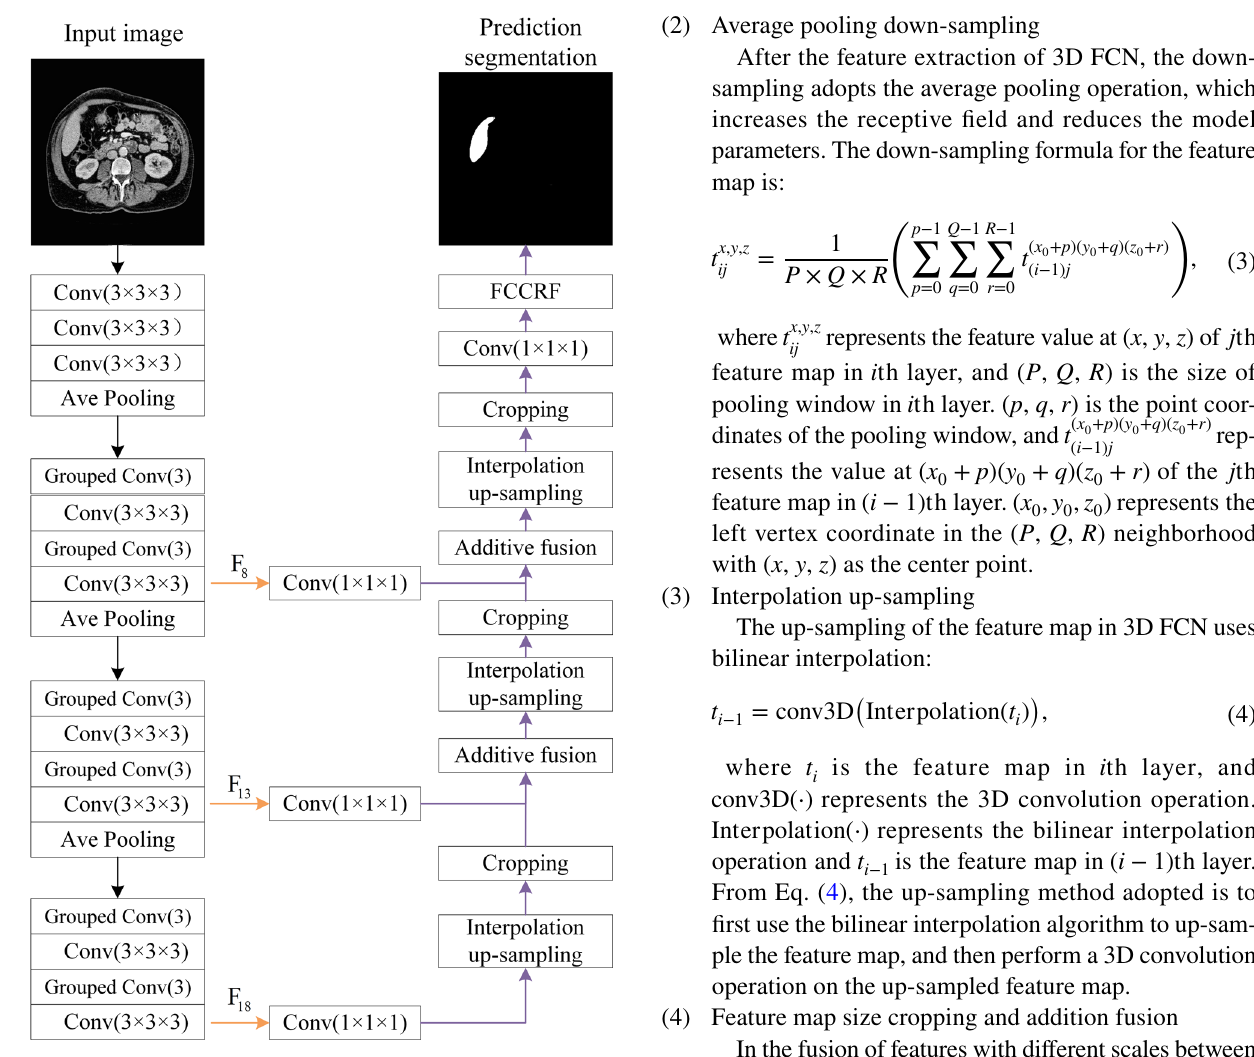
Fig. 5 Structure of 3D grouped fully convolutional network